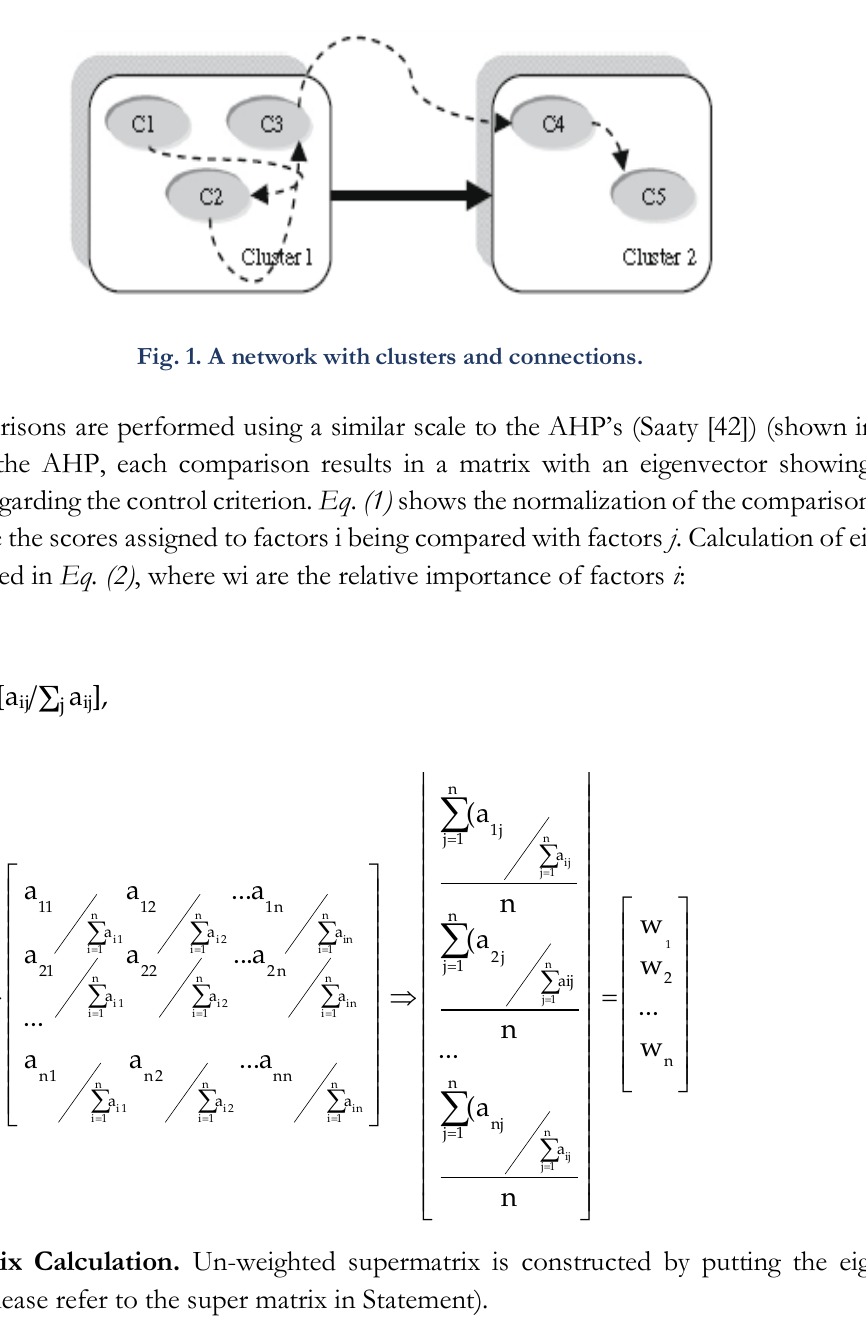
Table 1. Scoring scales pair-wise